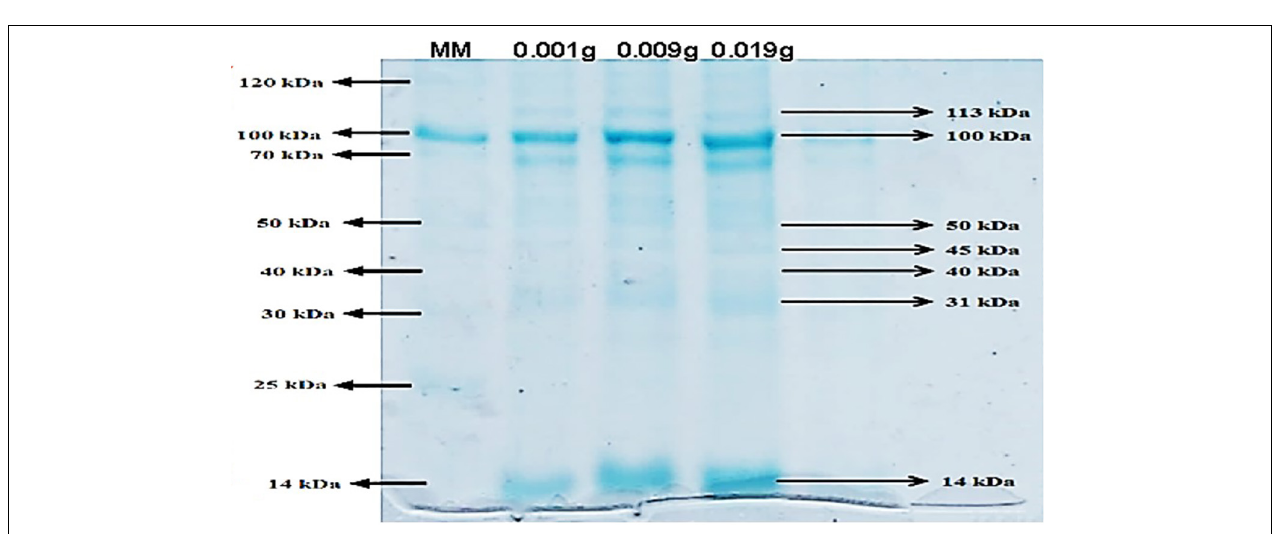
FIGURE 6 | Purified Human amniotic membrane proteins (HAMPs) on SDS-PAGE with a 10% separating gel and a 4% polyacrylamide stacking gel. MM stands for protein molecular weight marker, and Lane II-IV stands for purified HAMPs (Note the presence of 14–113 kDa proteins).